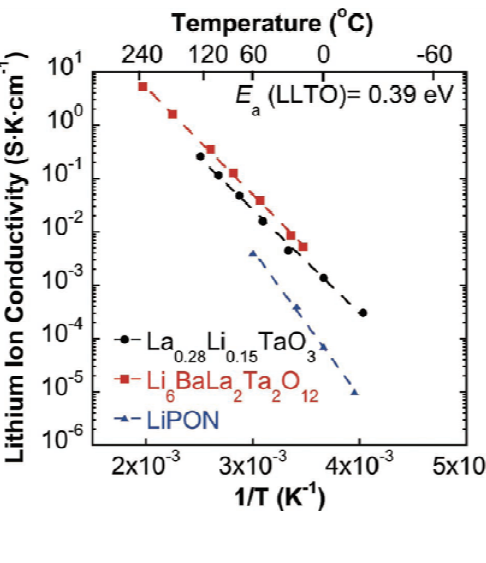
BaLa Ta O and lithium phosphorus oxy-nitride (LiPON) 6 2 2 12